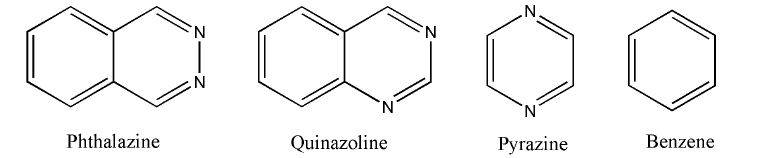
Figure 2. Isomers of Quinoxaline.